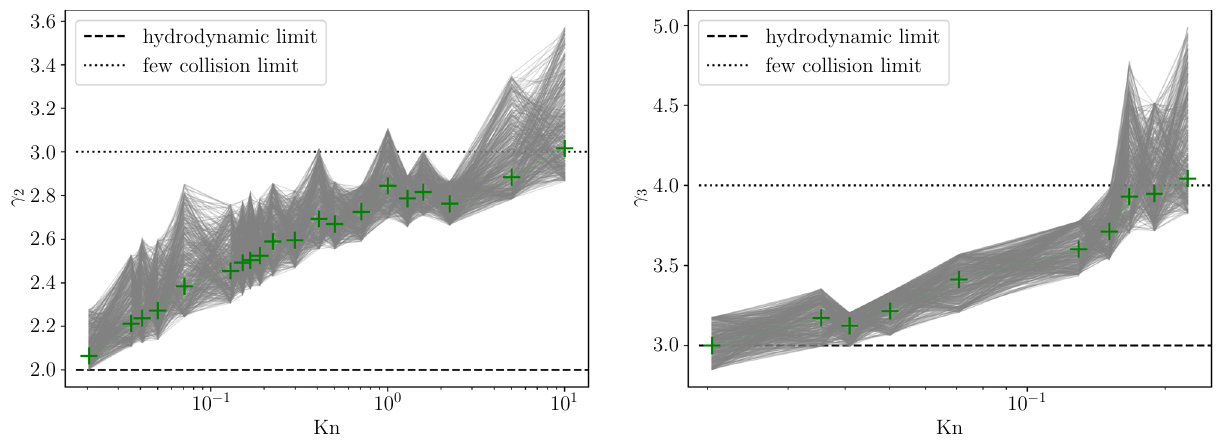
Fig. 2 Scaling exponent γ 2 (left) and γ 3 (right) as a function of the Knudsen number. The gray lines indicate the 500 realizations of the fit over different time intervals, while the green points correspond to the weighted average (12)